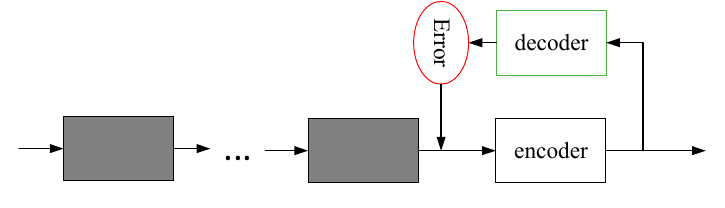
Figure 4. The diagram of stacking the process.